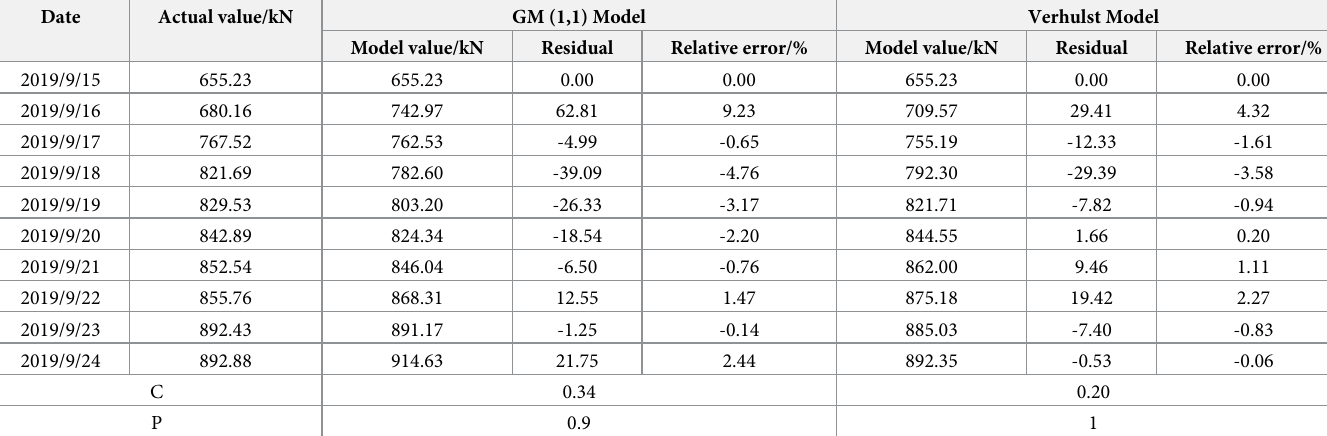
Table 6. ZG53-4 grey prediction model